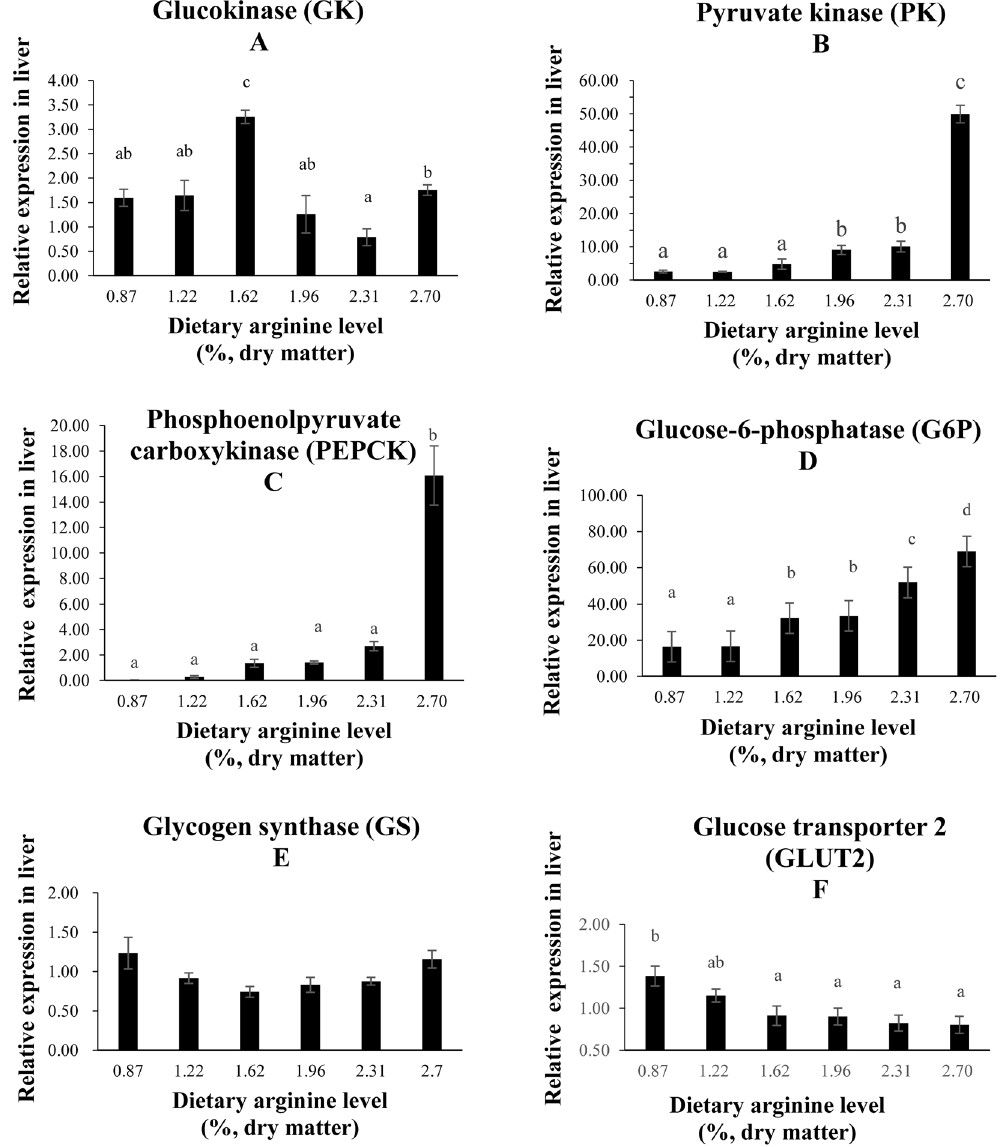
Data are expressed as means with SEM. Value with different superscripts are significantly different ( P < 0.05